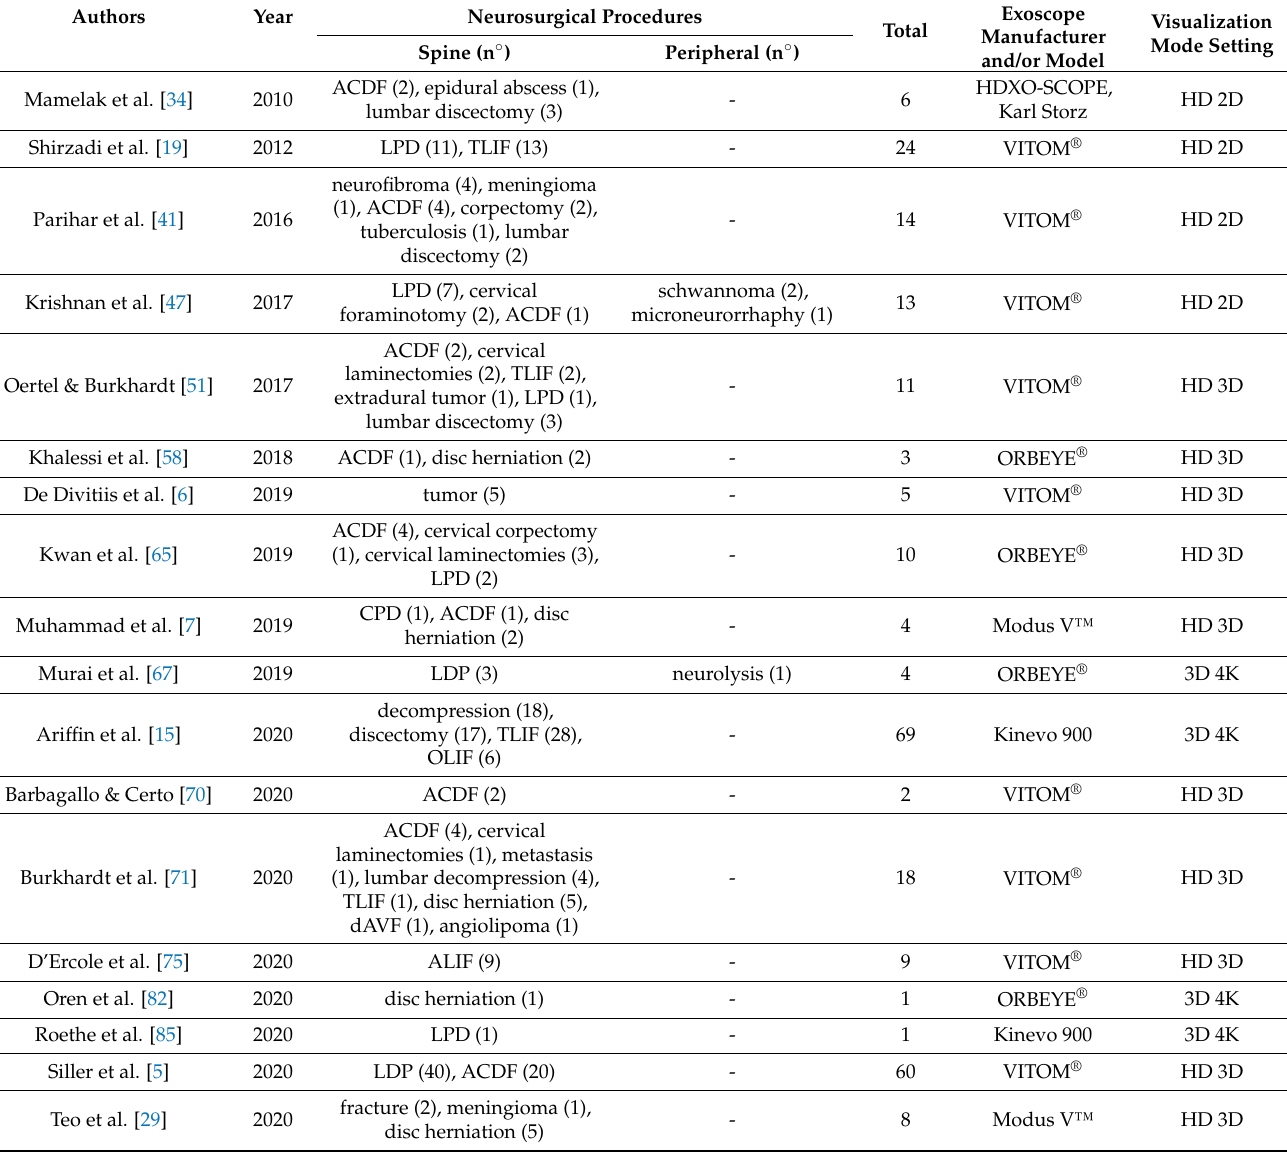
Table 3. Summary of spine/peripheral nerve studies included in the